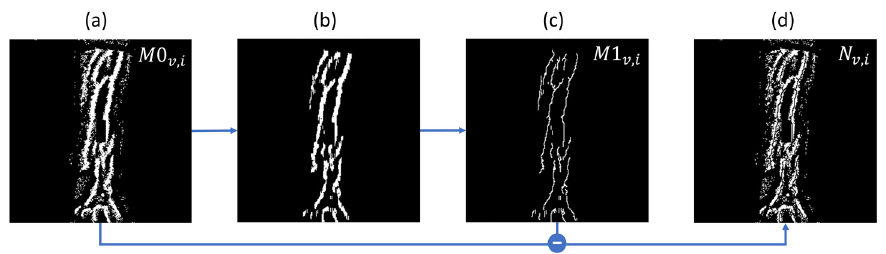
10 of 18 Figure 7. Overview 2D Label Generation components: ( a ) Niblack thresholding is applied on the prediction density map D , followed by a simulated annealing process, resulting in a local thresh ‐